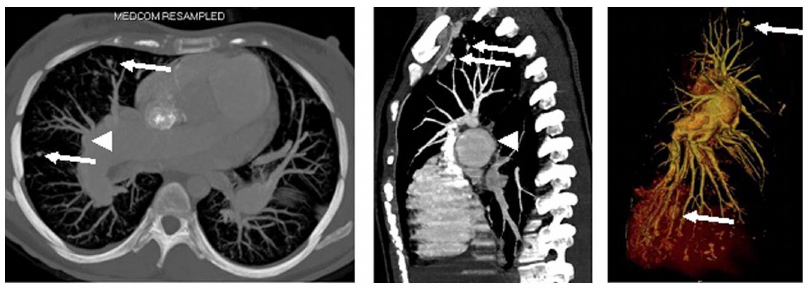
Figure 4. CT angiography from a 23 year old iPAH patient who died from massive hemoptysis. Panel A is a transverse section showing central pulmonary artery dilatation and small saccular aneurysms in more peripheral vessels (small arrows). Note the irregular borders of the central vessels. Panel B shows a coronal reconstruction with aneurysmatic changes to the main pulmonary artery (large arrow) and peripheral vessels (small arrows). Panel C is a 3 D reconstruction.